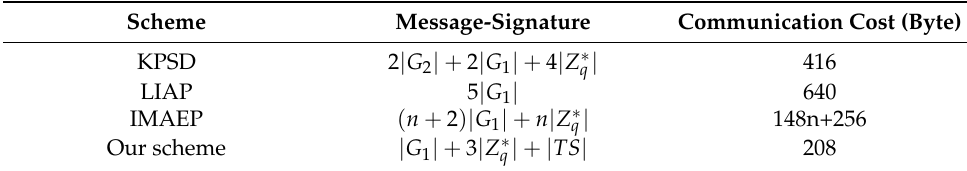
Table 4. The communication cost of